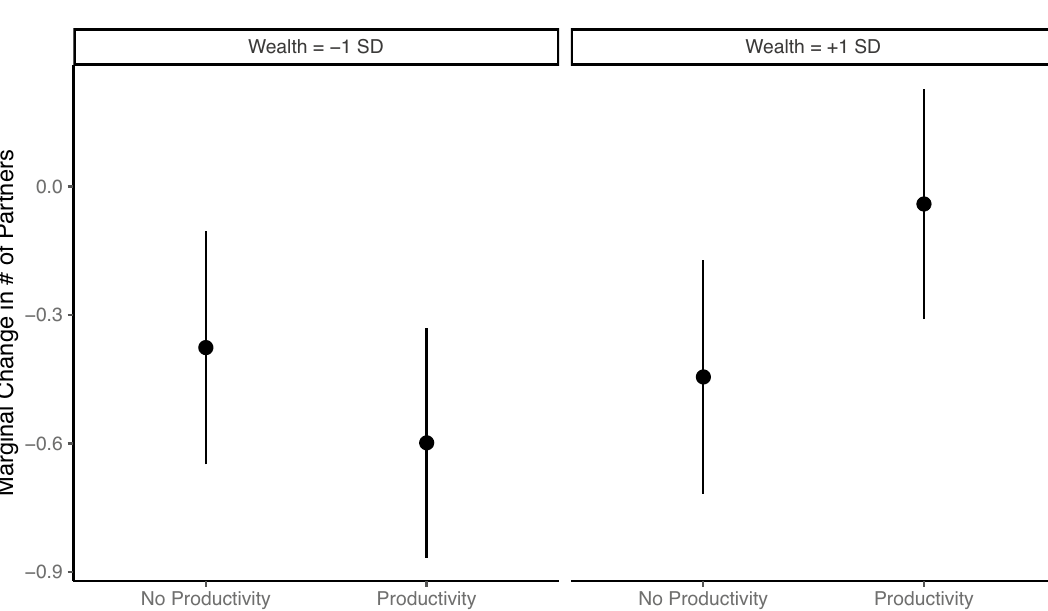
Figure 7. Marginal change in number of partners illustrating the interaction between participant baseline wealth and wealth